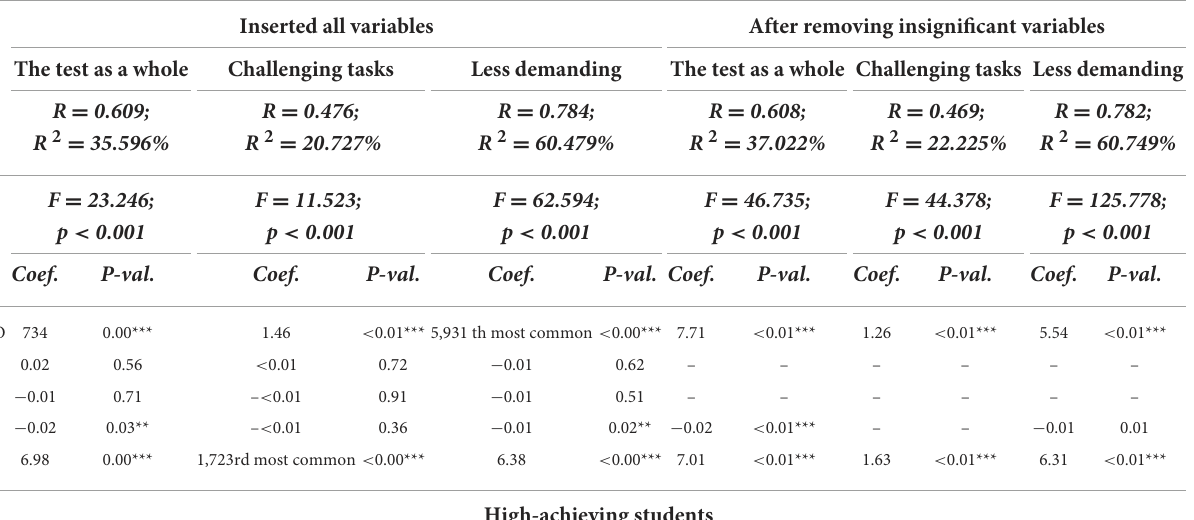
High-achieving students Inserted all variables After removing insignificant variables The test as a whole Challenging tasks Less